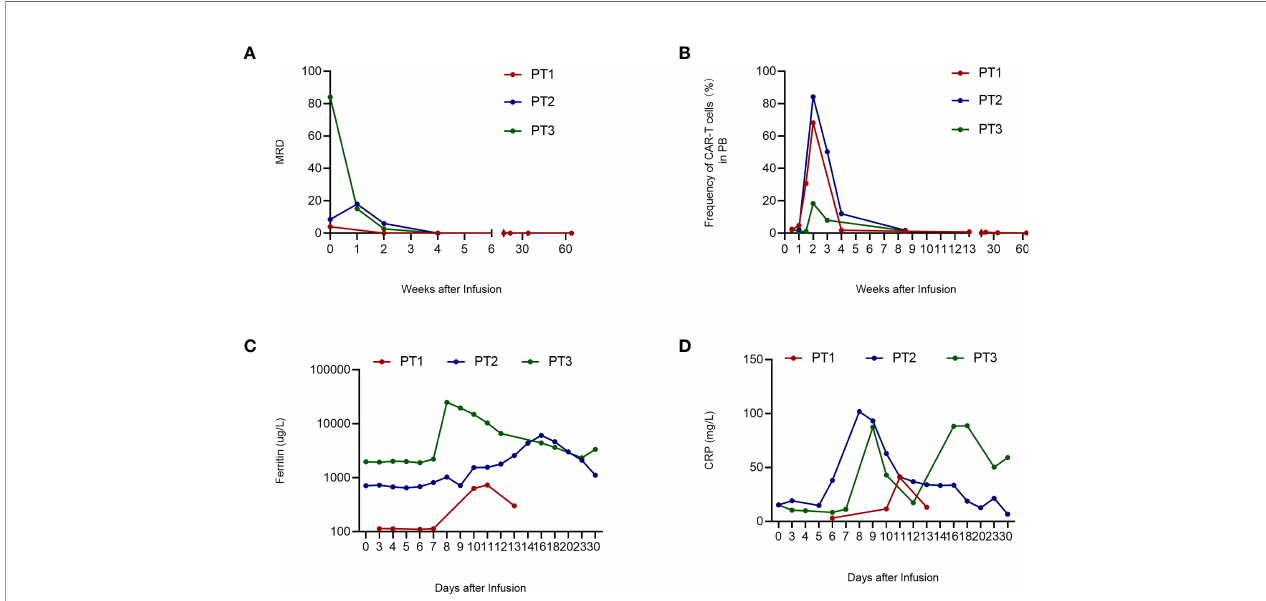
FIGURE 3 | Clinical evaluation after CAR-T cell infusion. A. MRD of 3 patients. PT1's MRD turned negative on day 14; PT2 ’ s and PT3 ’ s MRD turned negative on day 21 and remained negative during follow-up. B. Frequency of CAR-T cells in PB. The frequency of CAR-T cells in PB peaked on day 2 and then declined gradually. (C) Ferritin level of 3 patients. The ferritin level of PT1 was stable within 1 week after CAR-T cell infusion and peaked on day 11. PT2 and PT3 have higher ferritin levels that peaked on day 16 and day 8, respectively. (D) CRP level of 3 patients. PT1 ’ s CRP level peaked on day 11; PT2 ’ s CRP level peaked on day 8; PT3 ’ s CRP level has two peaks on days 9 and 18, respectively. WBC, white blood cells; CAR-T, chimeric antigen receptor-modi fi ed T cell; PT, patient; MRD, minimal residual disease; CRP, C-reactive protein; PB, peripheral